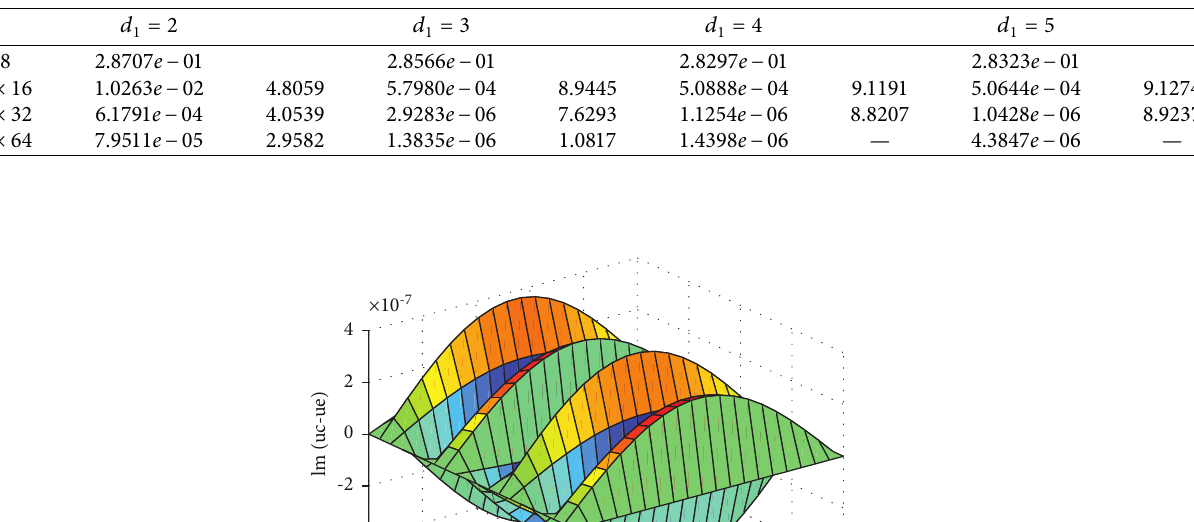
Table 3: Convergence rate of quasi-equidistant nodes with different d